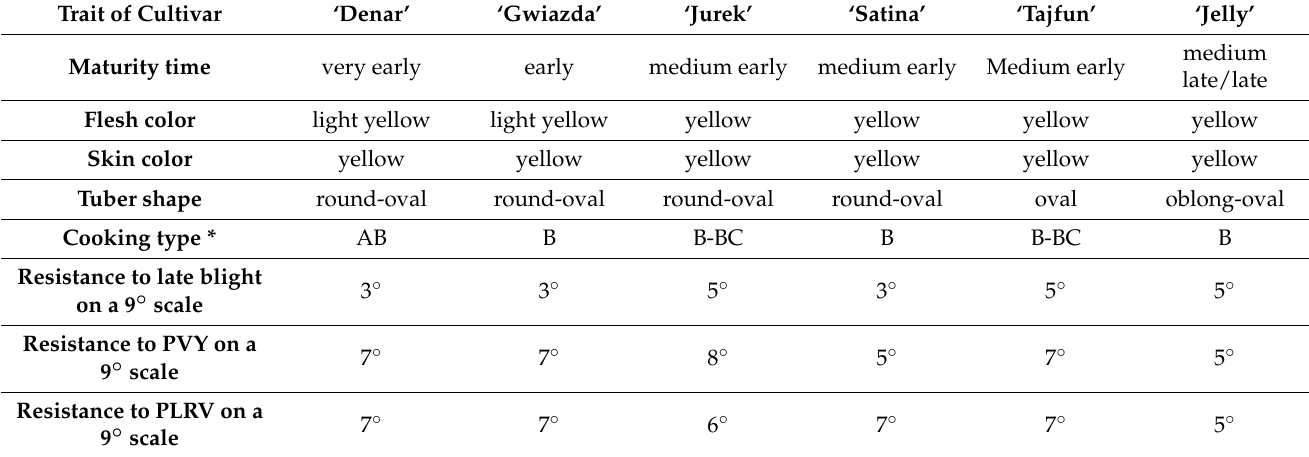
Table 2. A description of potato